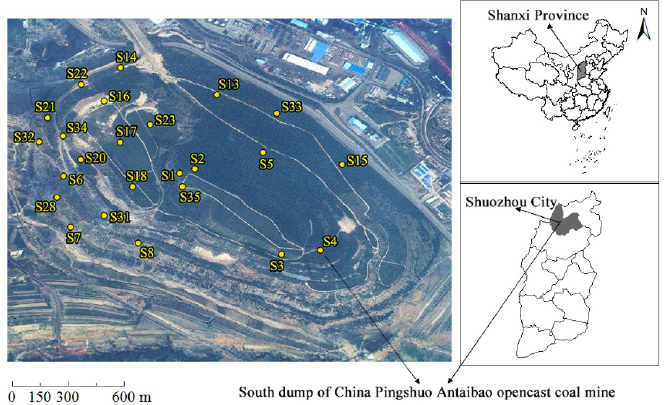
Figure 1. Locations of the study area and sample